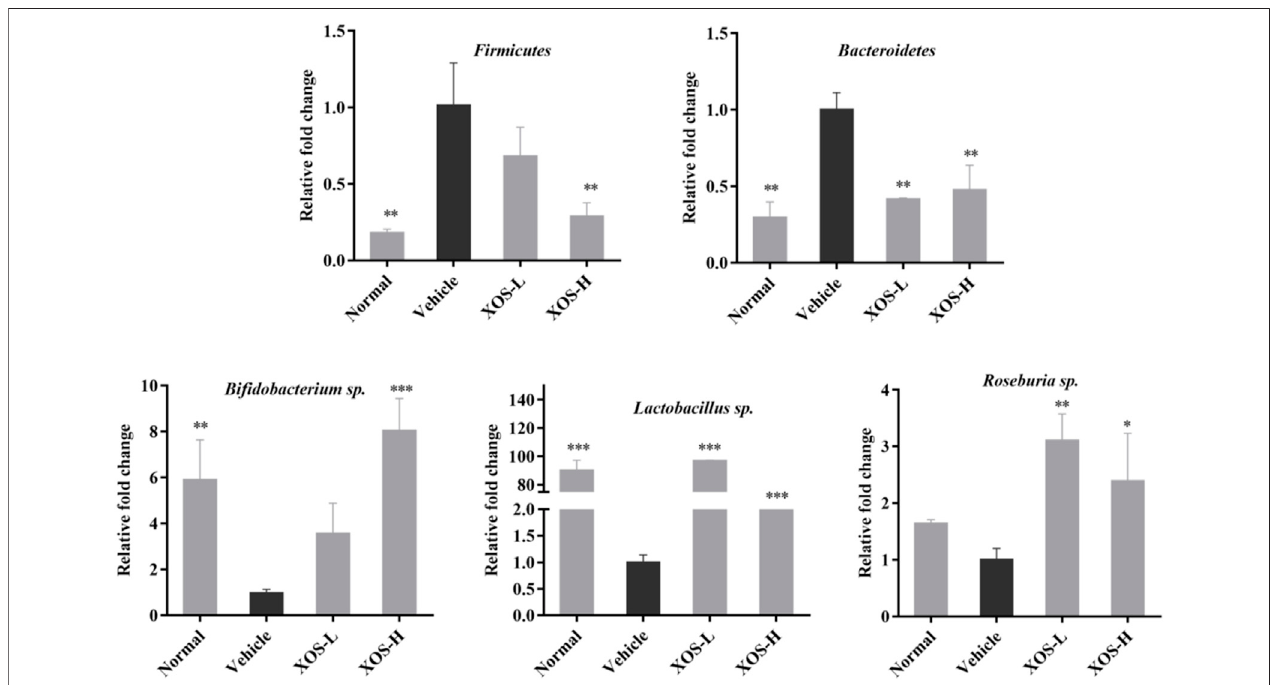
FIGURE10| EffectofXOSsupplementation on abundances of Firmicutes , Bacteroidetes , Bi fi dobacterium sp., Lactobacillus sp., Roseburia sp. XOS-L: mice treat with XOS 250 mg/kg, XOS-H: mice treat with XOS 500 mg/kg. * p < 0.05, ** p < 0.01, *** p < 0.001 compared with the Vehicle group.